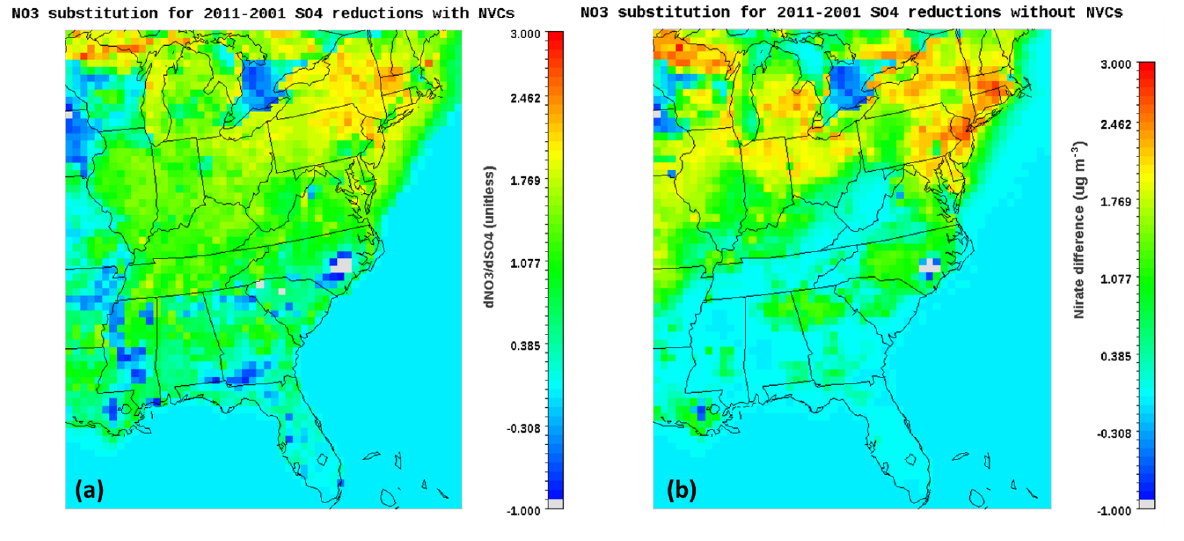
(cid:19) (cid:18) NO 2011 3 − NO 2001 3 over the decade, when NVCs are accounted for (a) , and when they are SO 2001 4 − SO 2011 4